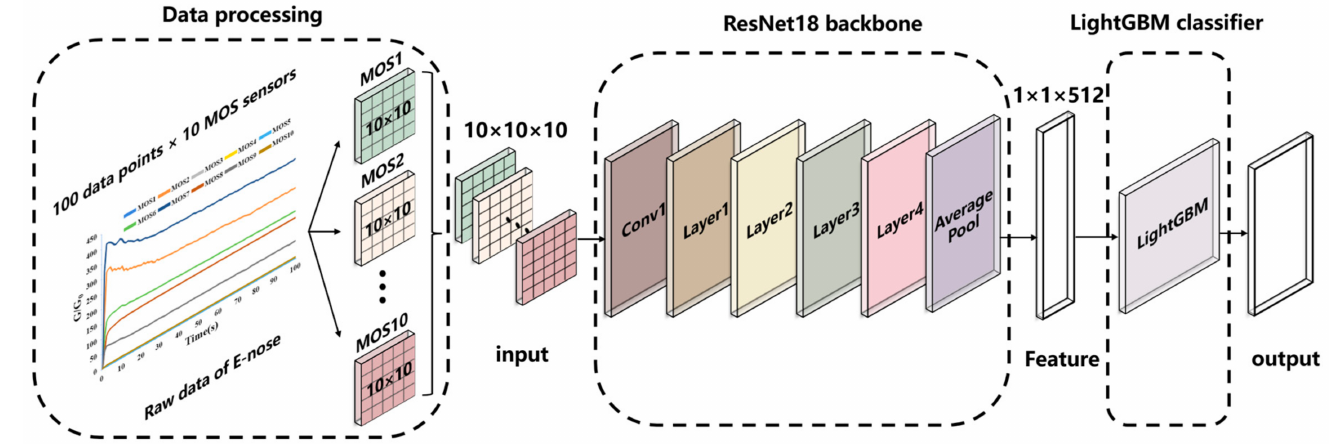
Figure 3. The classification framework for the quality detection of Chinese